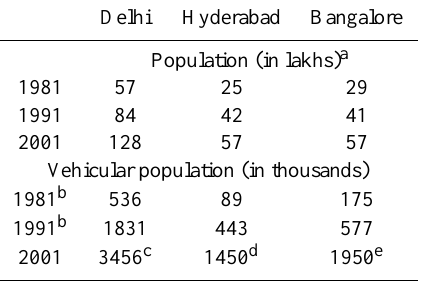
Table 3. Urban and vehicular population in 1981, 1991 and